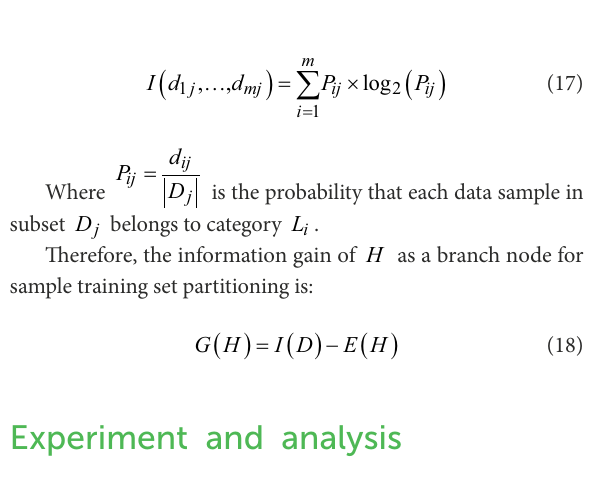
FIGURE 4 Results of model training.